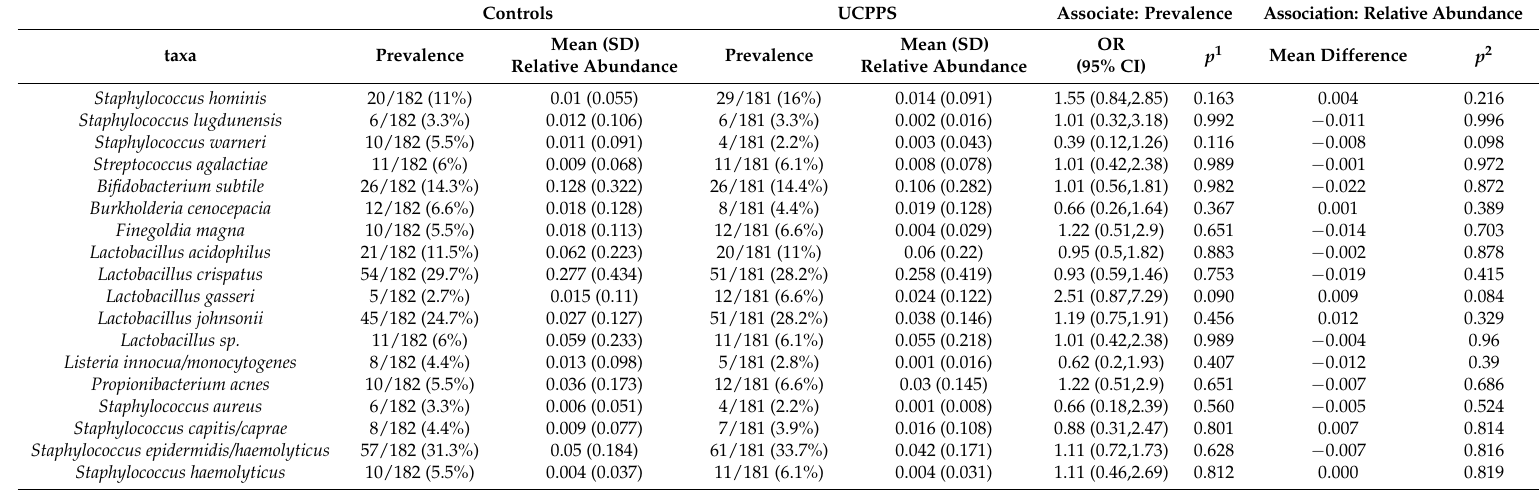
Table 5. Species-level differences in prevalence and relative abundance for urologic chronic pelvic pain syndrome (UCPPS) participants compared to Controls. Controls UCPPS Associate: Prevalence Association: Relative Abundance Mean (SD) Mean (SD) taxa Prevalence Prevalence Relative Abundance Relative Abundance